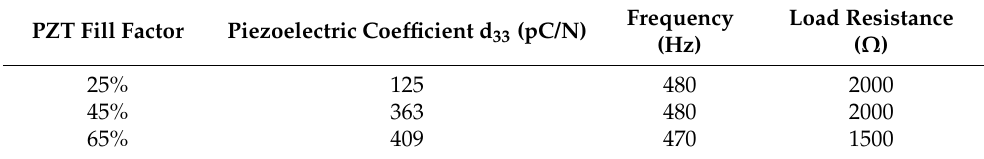
Table 1. Optimal power generation conditions for the composites.